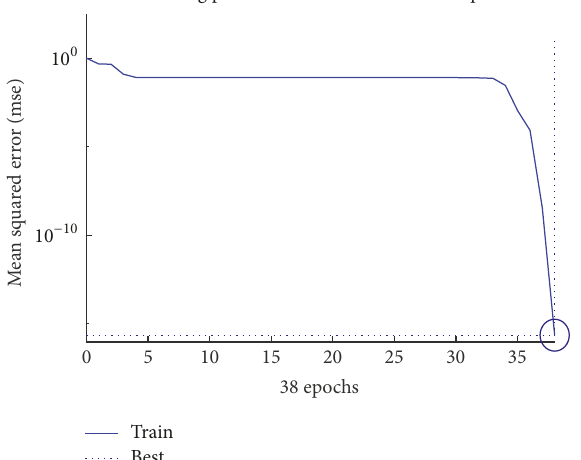
Figure 7: Evaluationof the quadraticerroras afunctionof thenumberof learning iterations(using themethodof retrogradientpropagation).